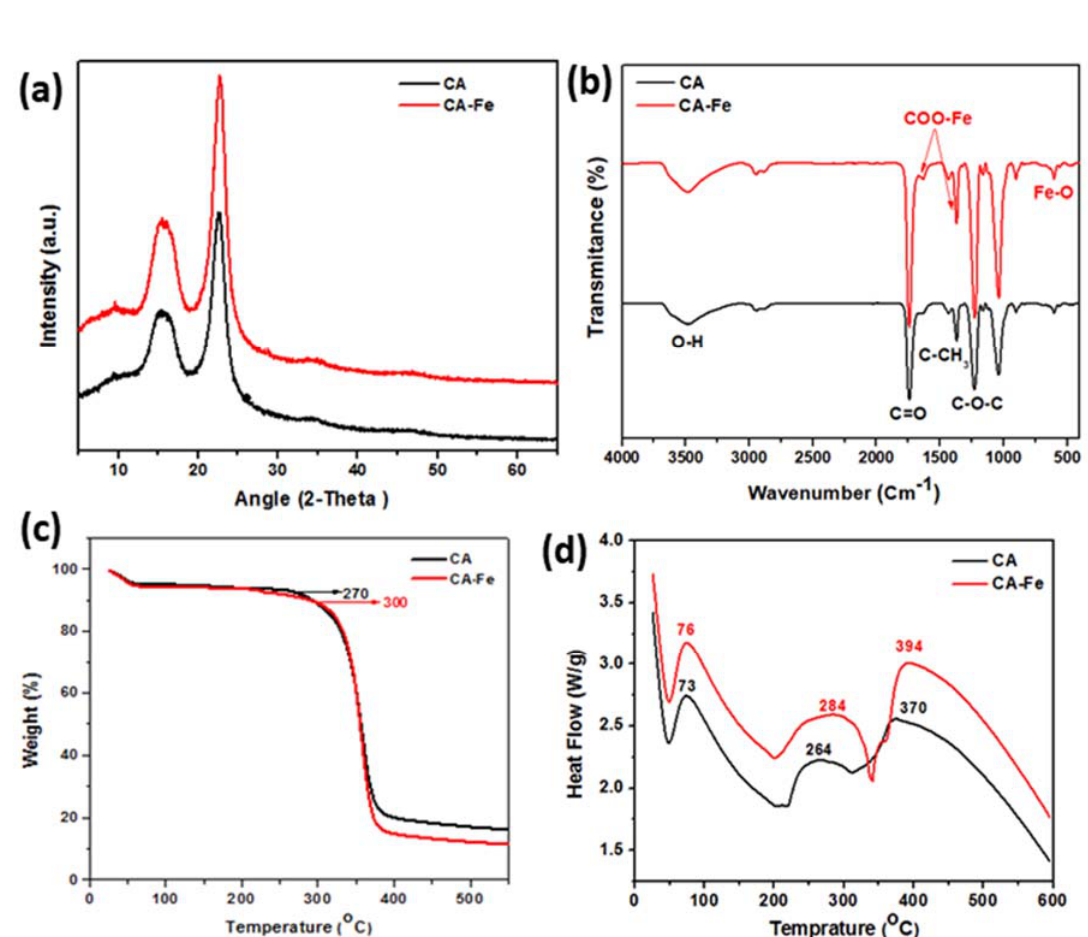
Figure 4. Mat characterizations for physiochemical and thermal properties: ( a ) XRD analysis and ( b ) FTIR analysis. ( c ) TGA analysis and ( d ) DSC analysis.